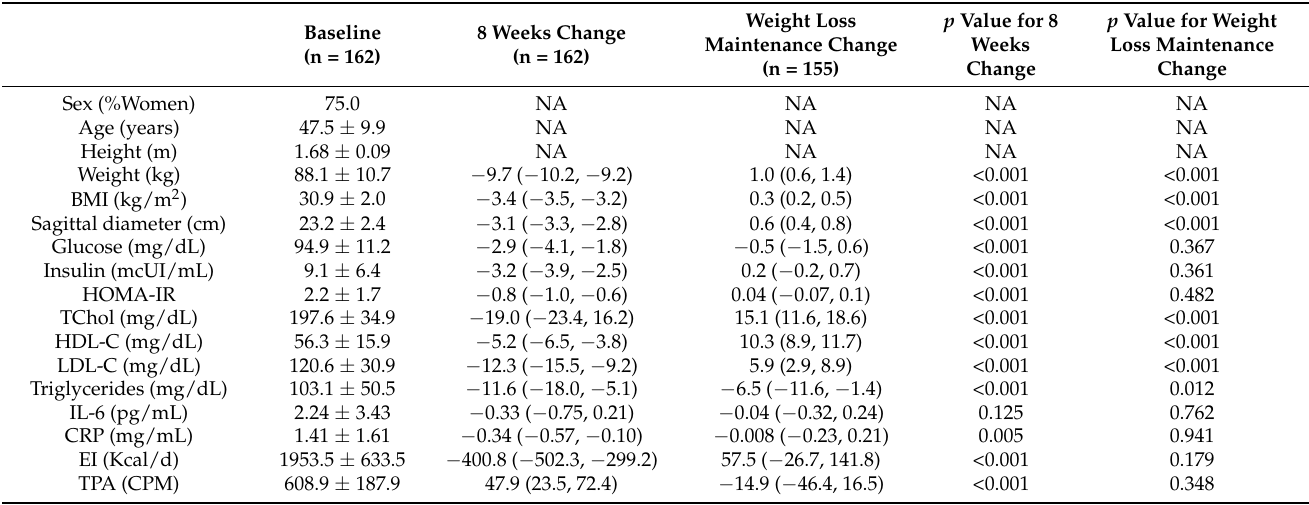
Table 1. General characteristics of the study subjects at baseline, after the 8-week LCD, and after the 12-week weight loss maintenance